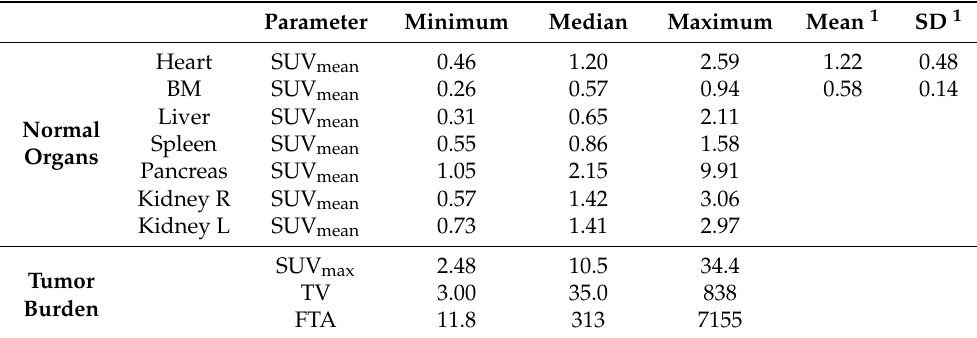
Table 2. Descriptive statistics of uptake in normal organs and tumor